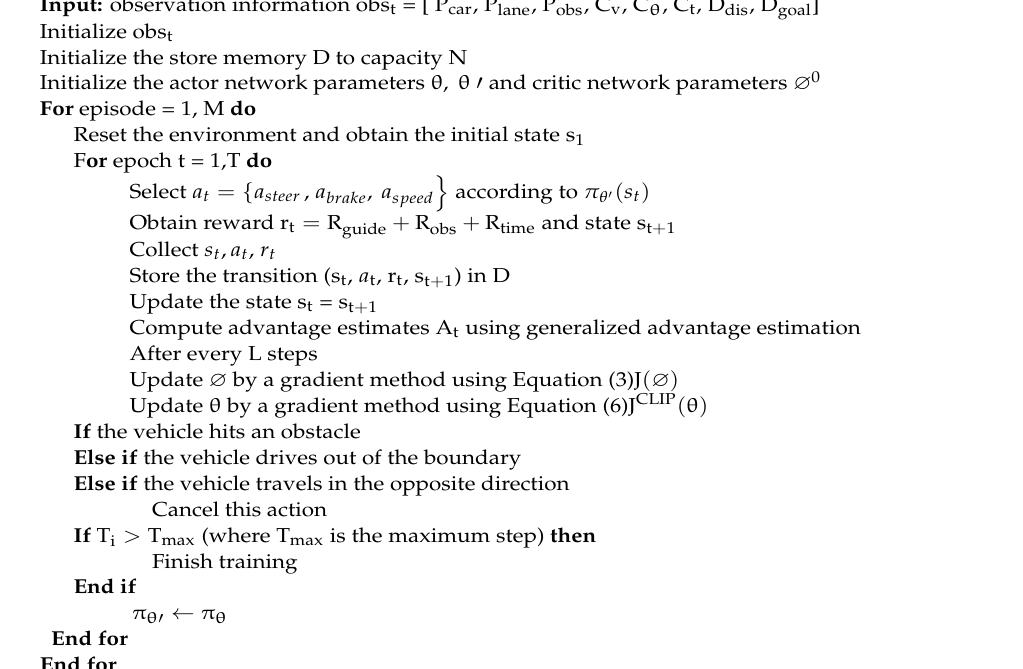
Algorithm 1 . APF-DPPO algorithm for vehicle autonomous driving